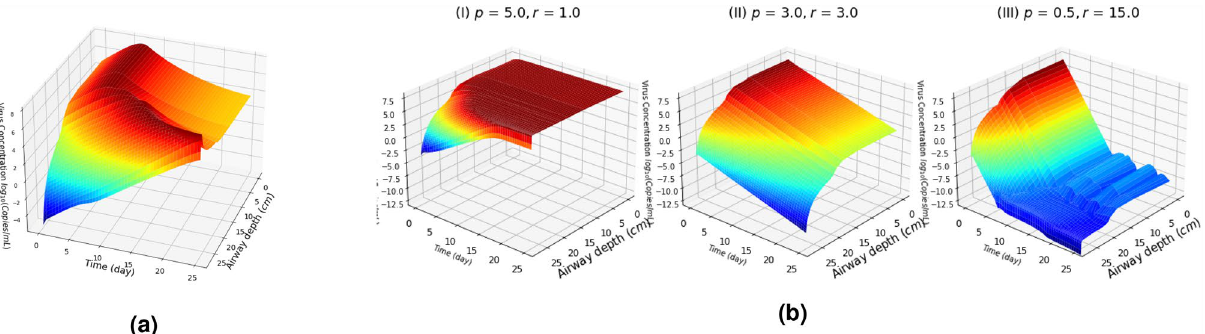
Figure 7. Virus load in the respiratory tract: (a) temporal dynamics in the virus load in the respiratory airway generations over time with the immune response by T-cells and (b) impact of the virus production rate p and the immune response by T-cells r on the temporal dynamics in virus load for three cases: p > r , p p << r (other parameters are fixed to the values given in Table 1).